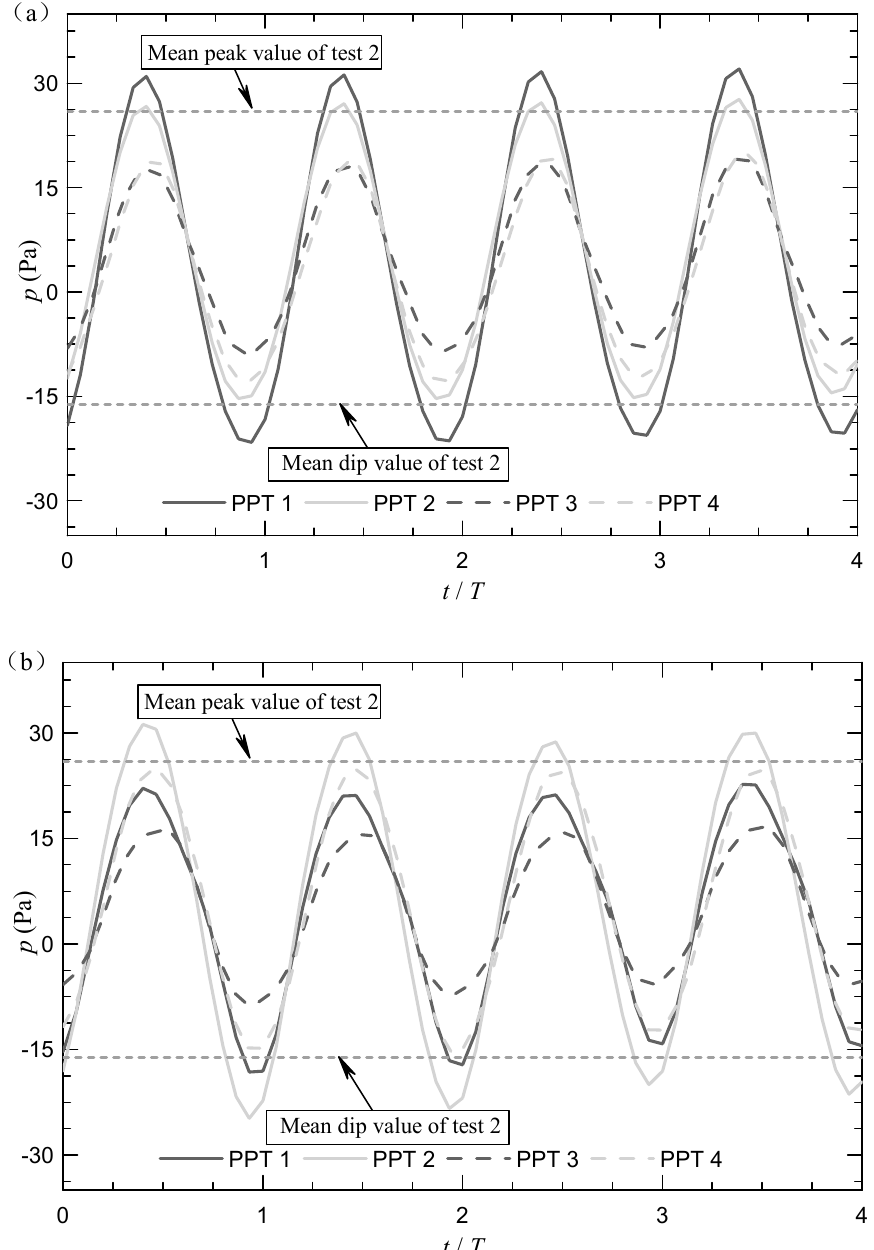
Figure 7. Effect on the distribution of excess pore pressure caused by mat foundation in ( a ) test 5 (Waves: H = 10 cm, T = 1.5 s; Mat foundation: position A; No current) and ( b ) test 8 (Waves: H = 10 cm, T = 1.5 s; Mat foundation: position B; No current).